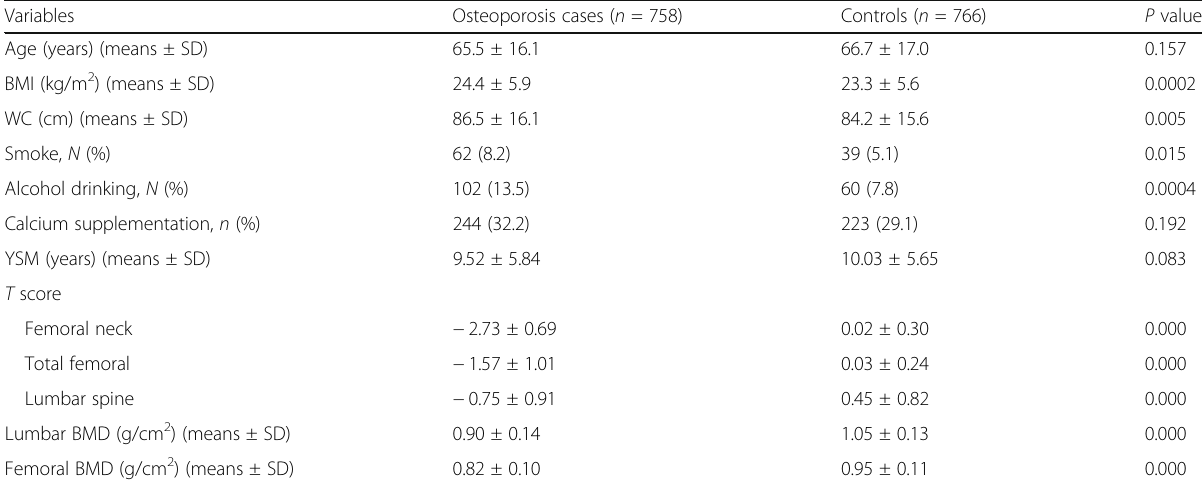
Table 2 General characteristics of study participants in case and control group